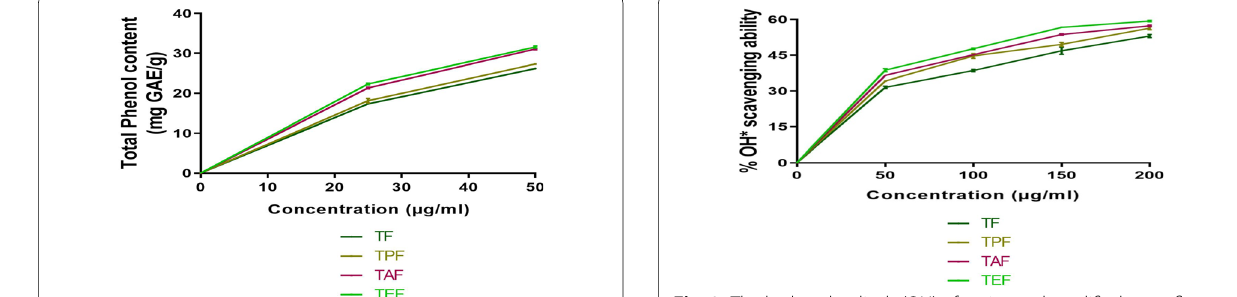
Fig. 1 Total phenol content in native and modified tacca flour. TF: Native tacca flour, TPF: tacca physical flour, TAF: tacca acetylated flour, TEF: tacca enzymatic starch